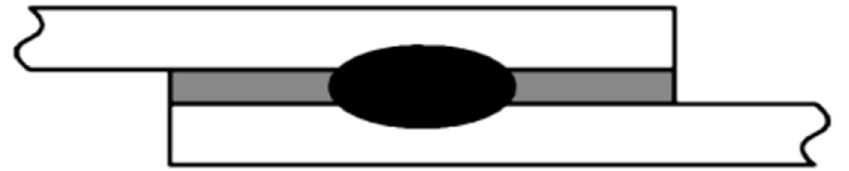
Figure 4. Weld ‐ bonded joints result from the combination of adhesive bonding with resistance spot ‐ welding based on